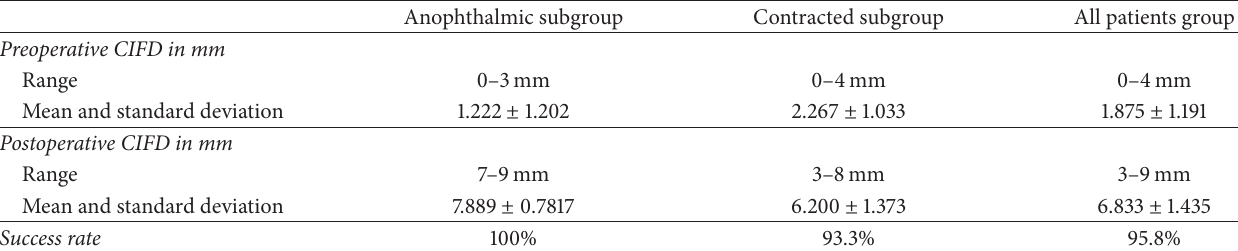
Table 3: Preoperative and postoperative CIFD and success rate in anophthalmic and contracted subgroups and in all patients